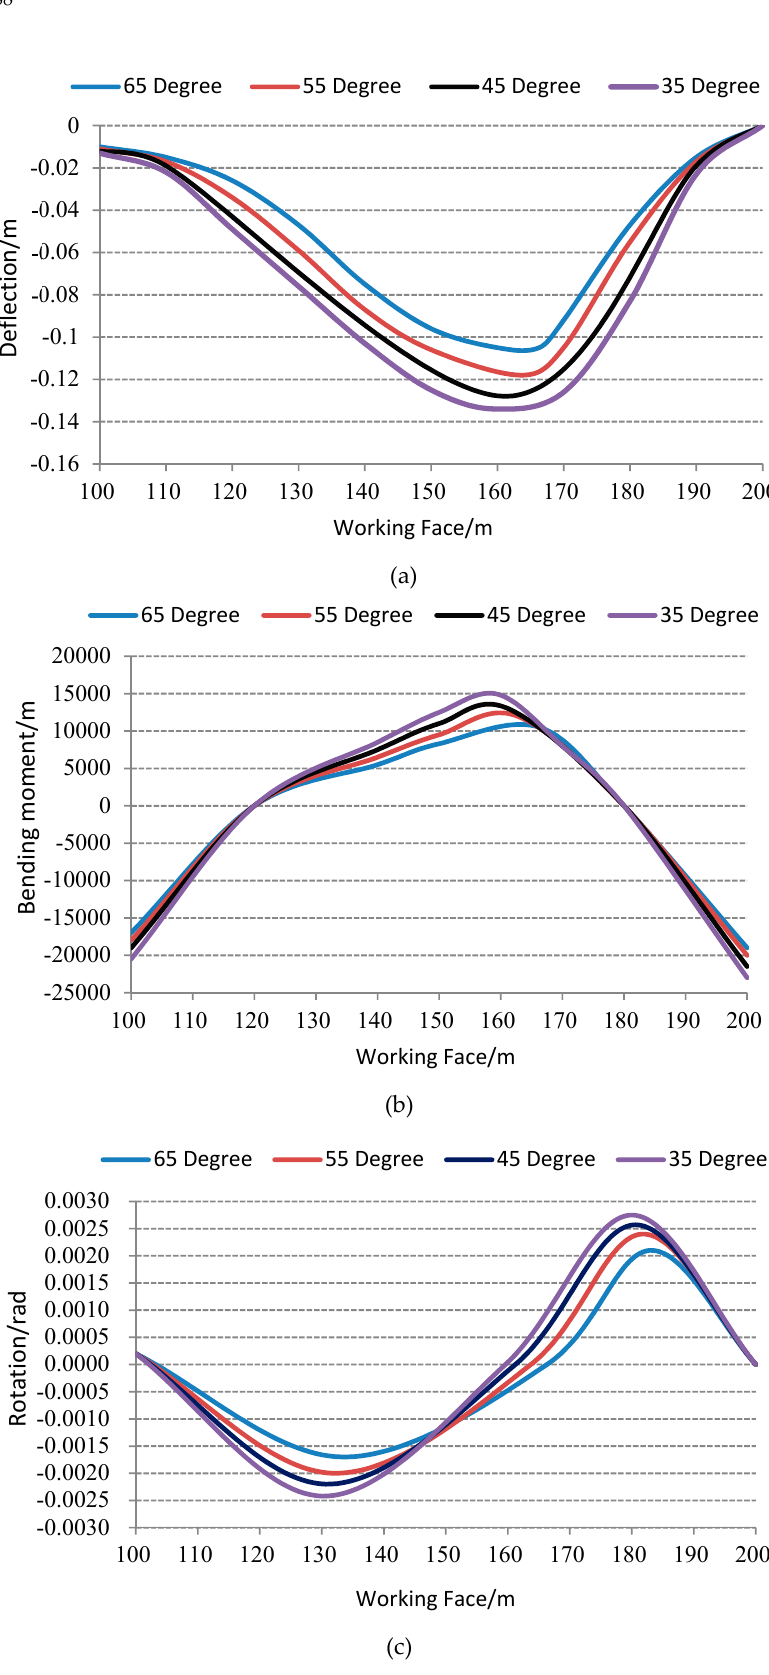
Figure 4. Roof deformation and internal force under different inclination angles: ( a ) Deflection; ( b ) bending moment; and ( c ) rotation.